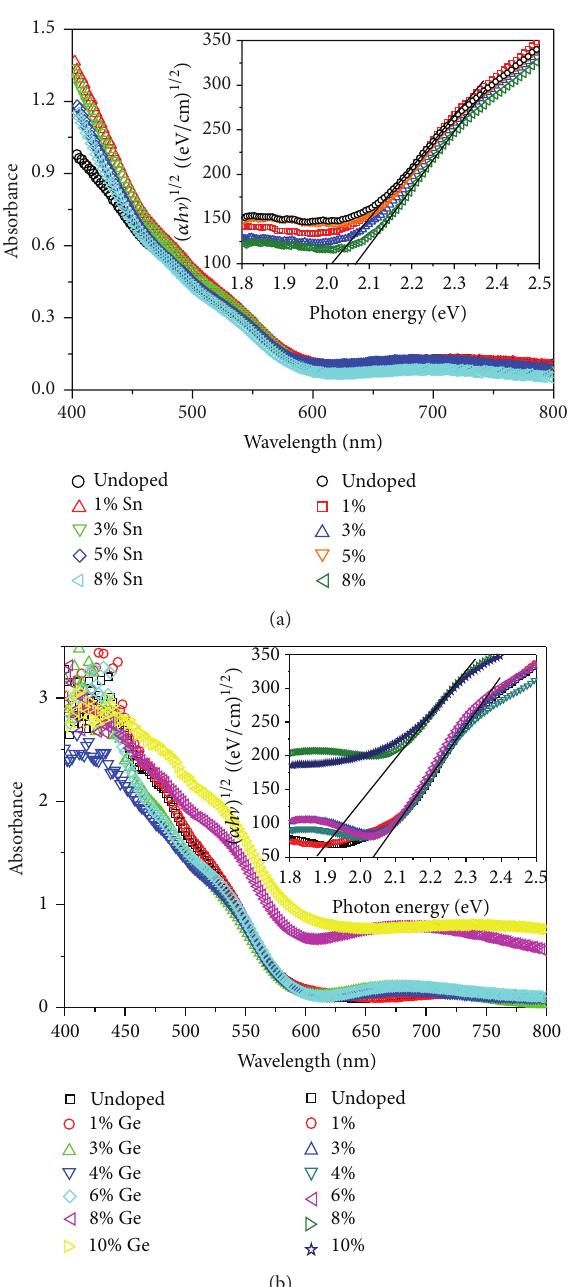
Figure 2: Optical absorption spectra (absorbance versus photon energy) for thermal oxidized hematite films doped with (a) Sn and (b) Ge. Inset: the corresponding Tauc